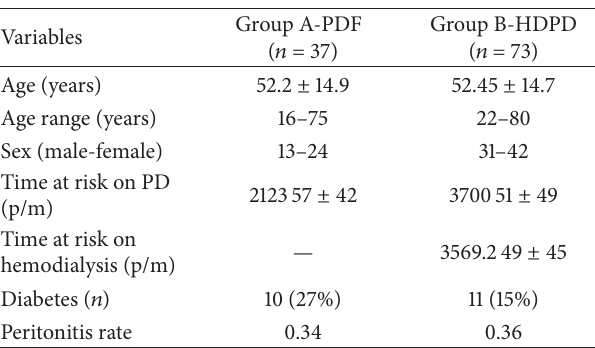
Table 1: Patients